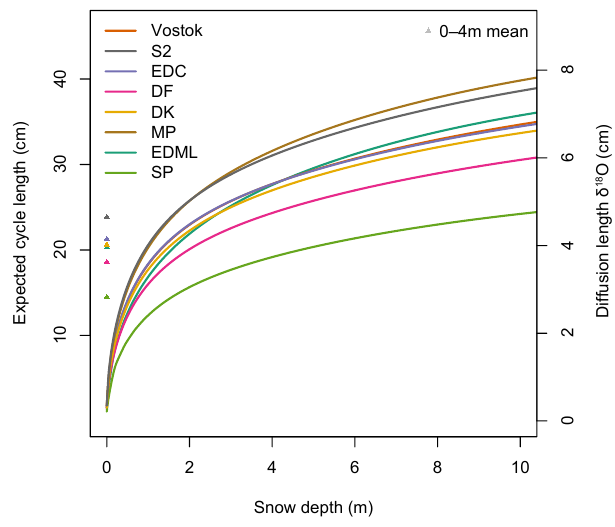
Snow depth (m) Figure 3. Modelled diffusion lengths for the different sites. The dif- fusion lengths for δ 18 O (right scale) are shown against depth. Also shown are the implied cycle lengths (left scale) assuming diffused white noise. For most sites, the mean cycle lengths in the top 4m (triangles) are around